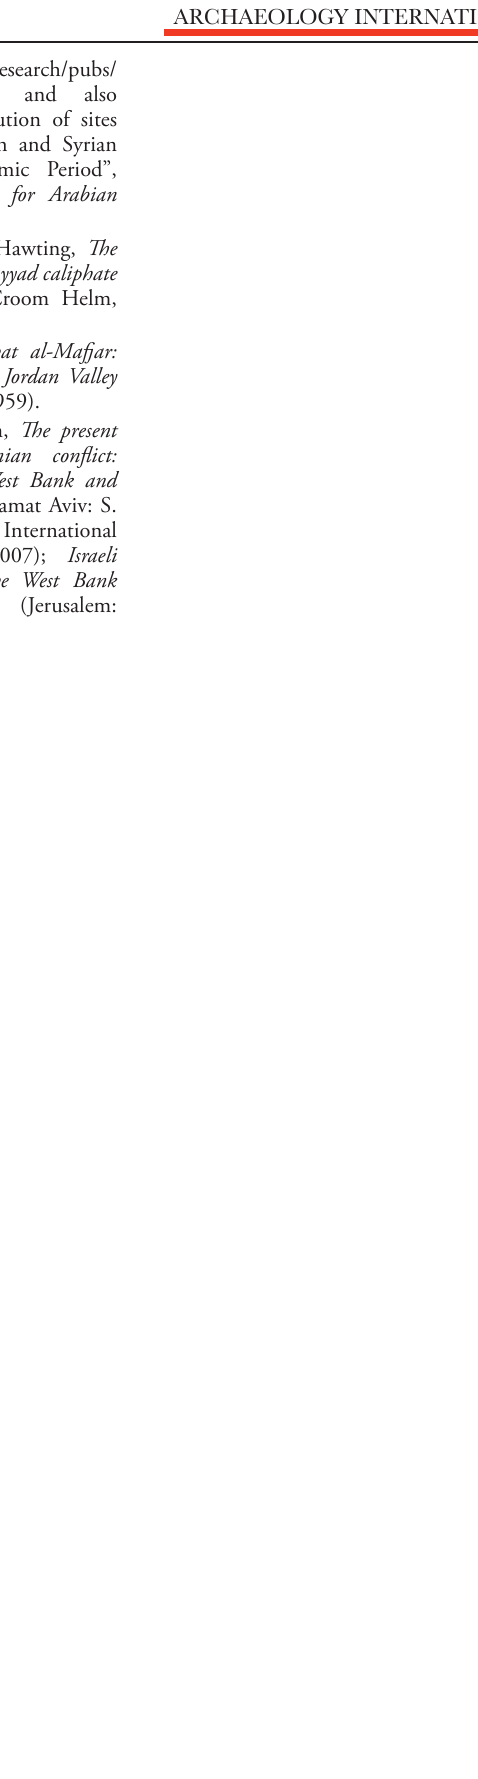
Figure 8 The two caravanserai at location KRS02, clearly visible on the satellite image.